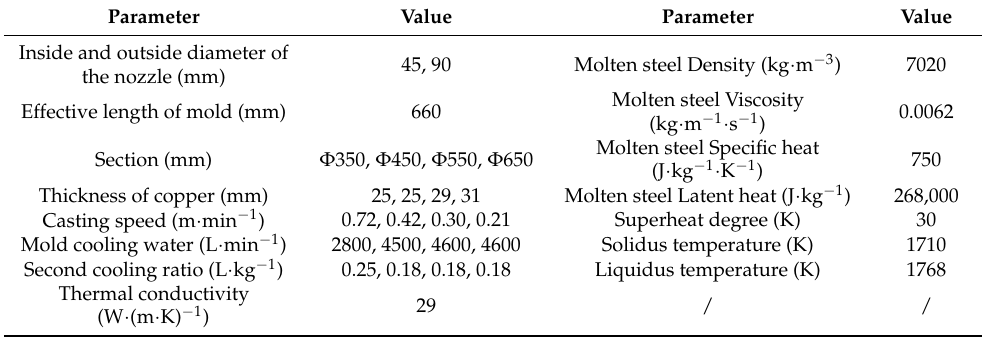
Table 2. Parameters of the round bloom CC and thermophysical parameters of 42CrMo steel. Parameter Value